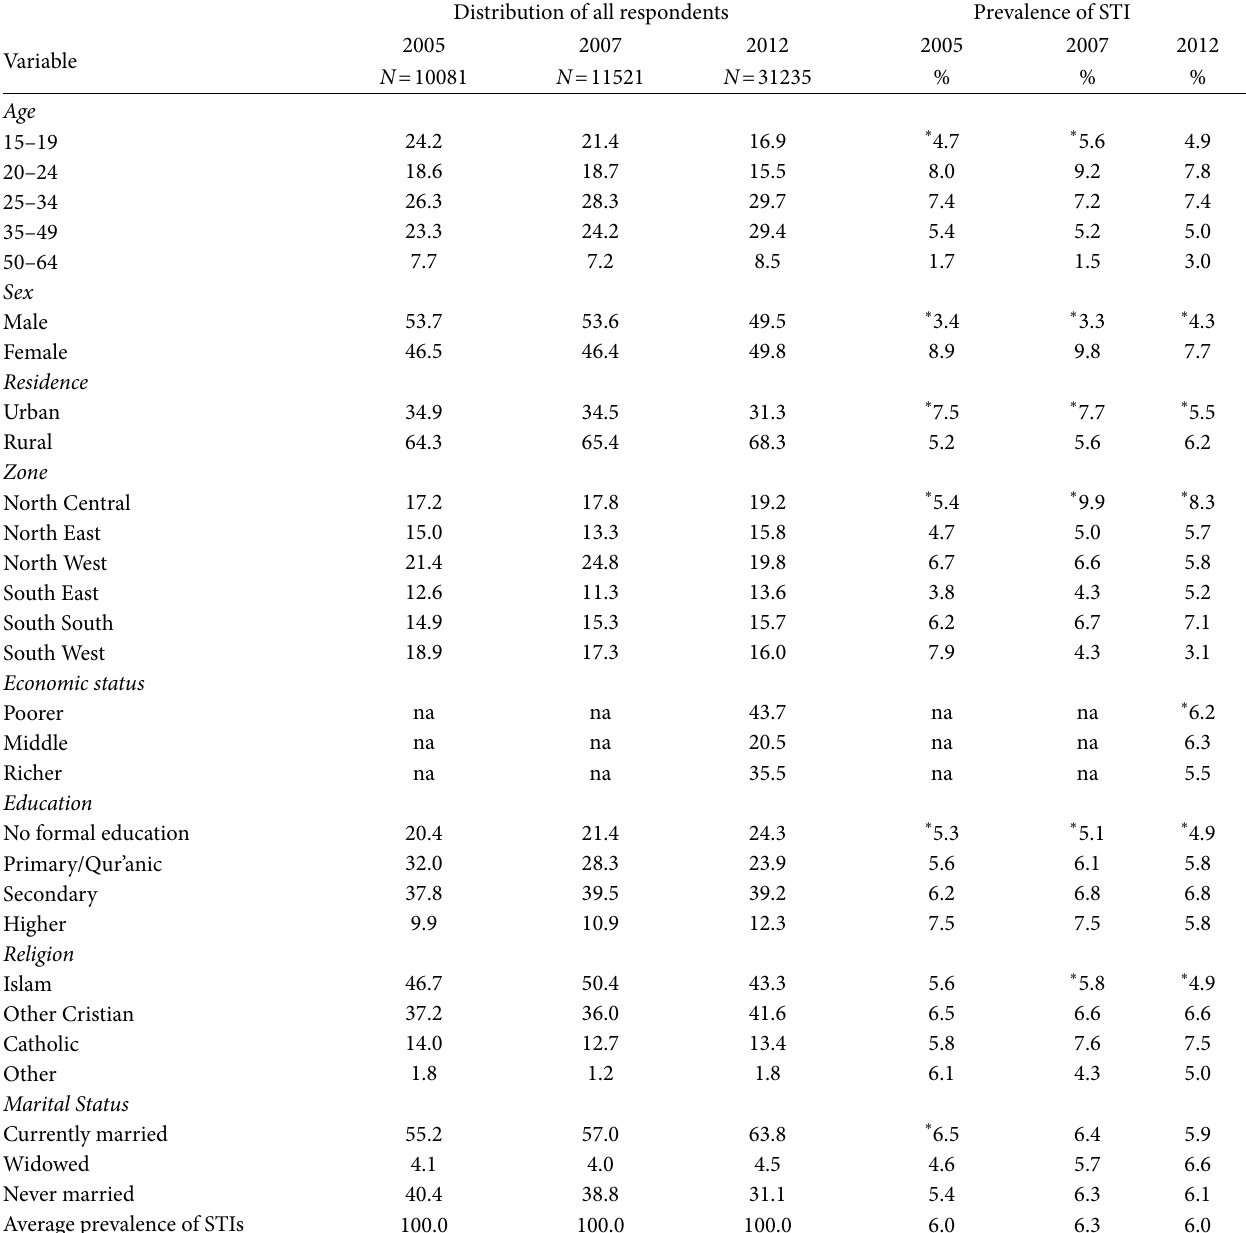
Table 2: Distribution of respondents and the Prevalence of STI by respondents